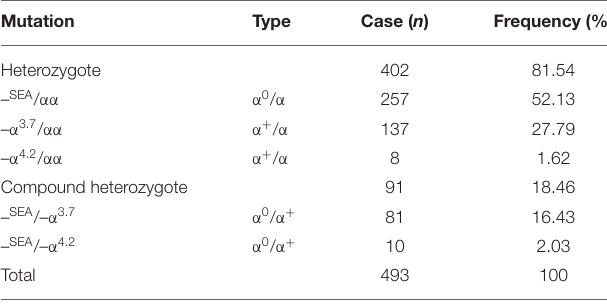
TABLE 1 | Frequency of α -thalassemia mutations in children in the Yunnan